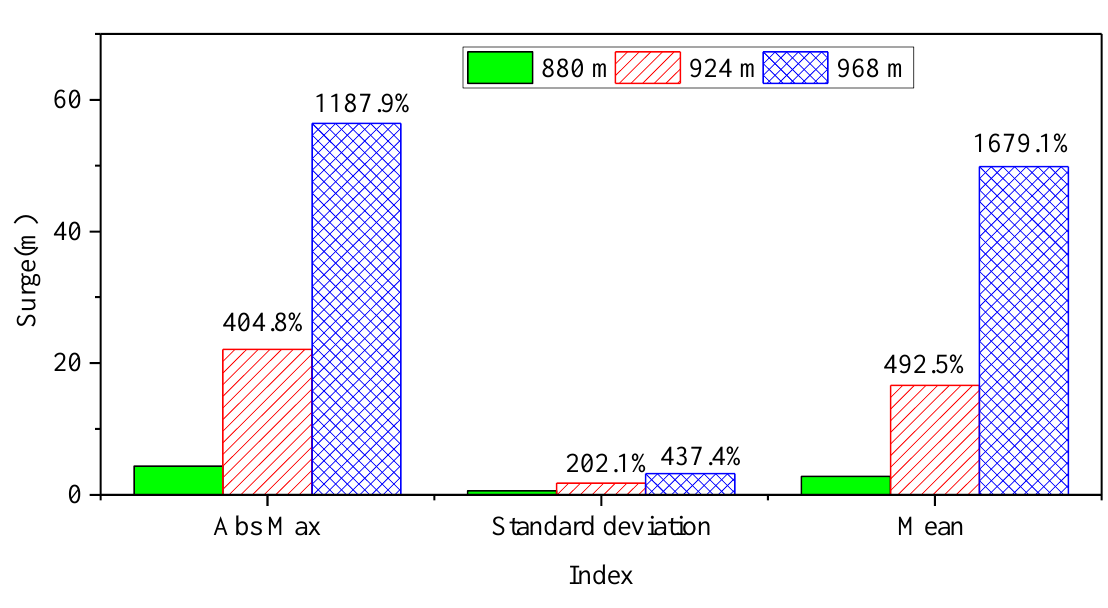
Figure 19. Comparison of time histories of the fishing cage and wind turbine responses for three mooring line lengths under case 3. ( a ) Cage responses. ( b ) Wind turbine responses.